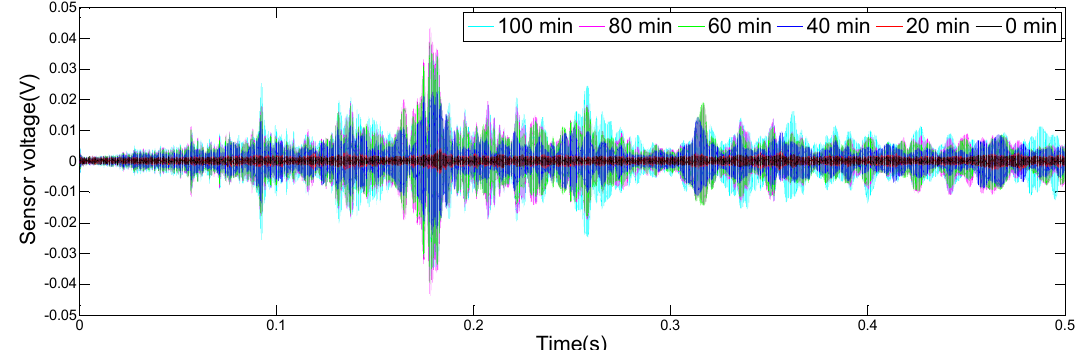
Figure 11. Signal received by SA2 (0–100 min).